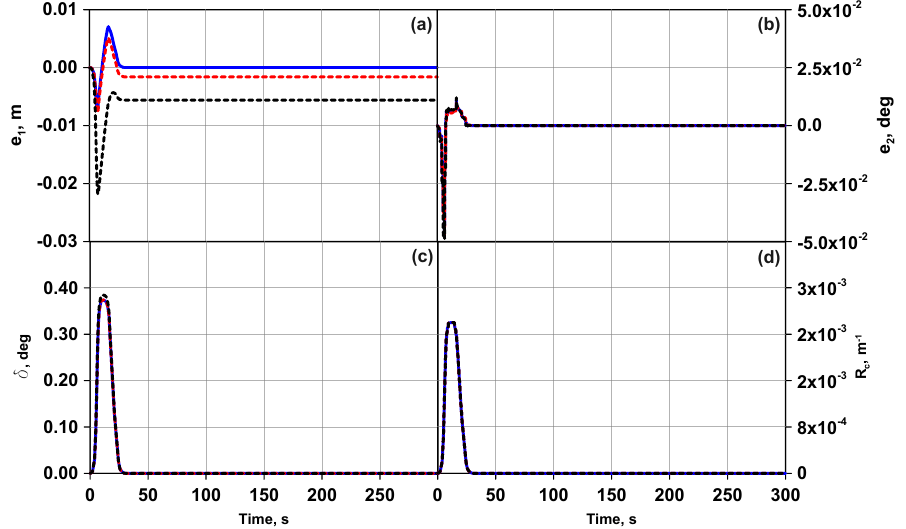
Figure 12. Robustness test (blue: nominal values, dashed red: maximum values, dashed black: minimum values)—( a ) lateral displacement (m); ( b ) yaw angle error (deg); ( c ) steering angle at the wheels (deg); ( d ) road curvature (m − 1 ).